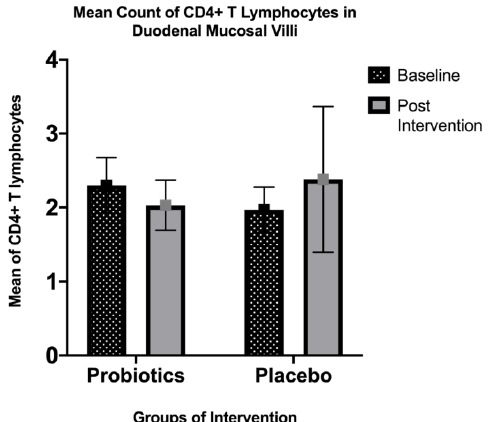
Figure 3. Immunohistochemical staining analysis of CD4+ T lymphocytes in the villi of the duodenal mucosa in NAFLD patients. There was a slight decrease in the mean count of intraepithelial CD4+ T lymphocytes observed in the probiotics group after 6 months of the intervention (from 2.30 ± 1.83 to 1.97 ± 1.50; p = 0.35), while the placebo group showed a slight increase in the mean intraepithelial CD4+ T lymphocyte count (from 2.03 ± 1.68 to 2.38 ± 4.82; p = 0.63). Both groups did not show any significant